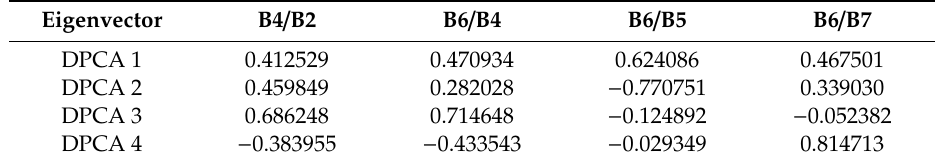
Table 2. Eigenvector matrix of the Landsat-8 band ratio indices derived from the directed principal components analysis (DPCA) for the Inglefield Mobile Belt (IMB) selected subset